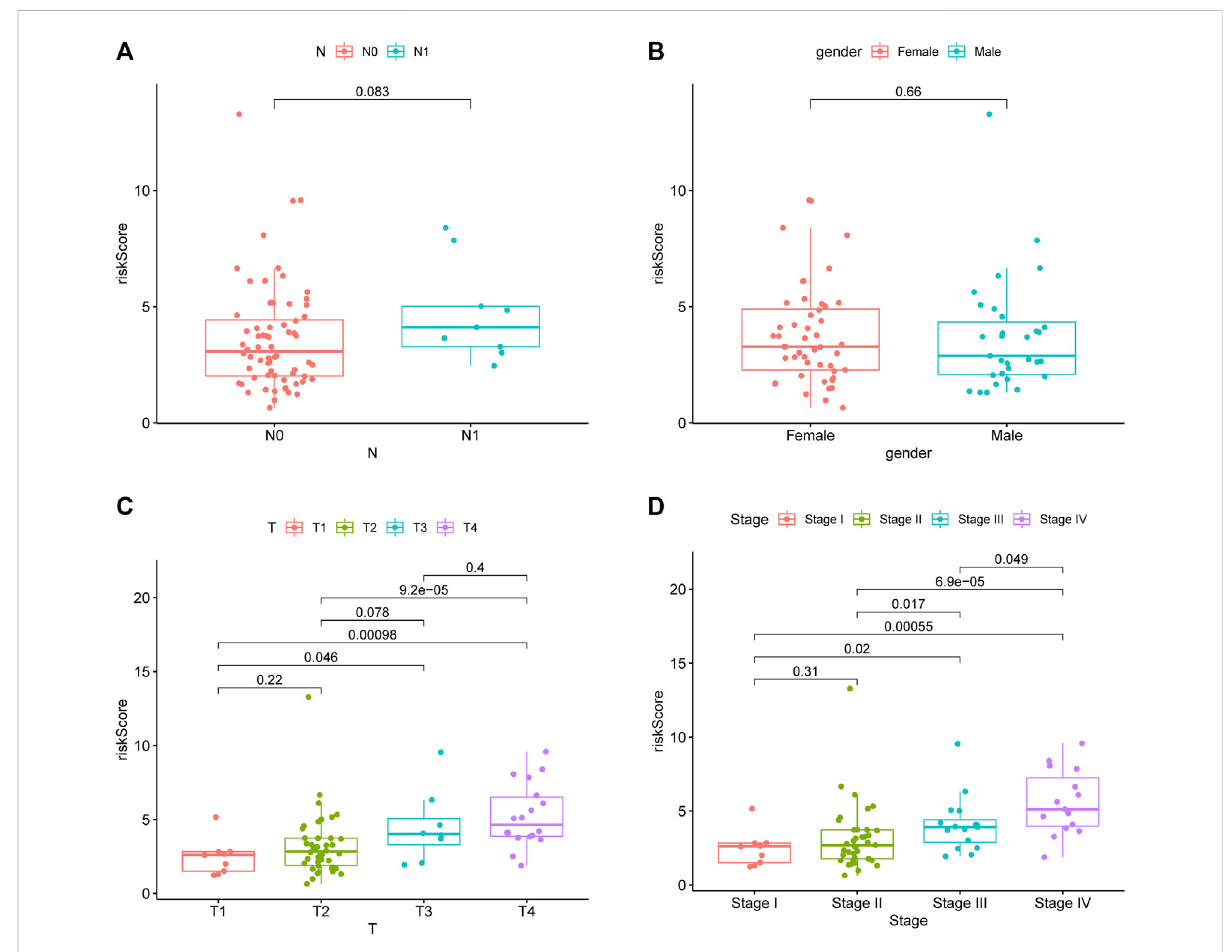
FIGURE 3 Riskscore in different gender, clinical stage, clinical T stage and clinical N